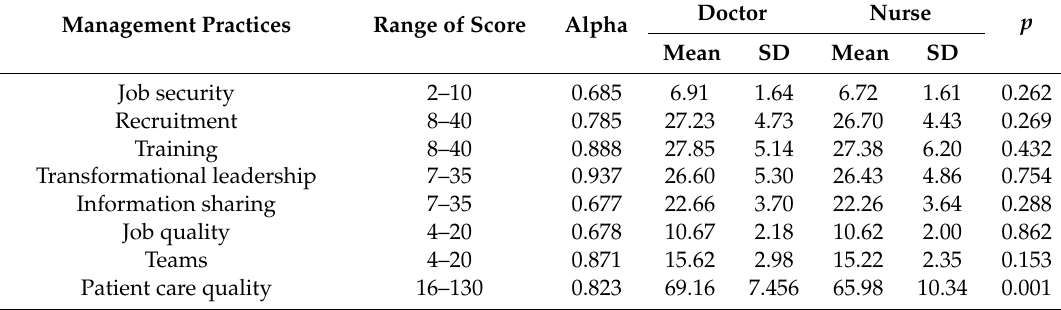
Table 2. Perceptions of doctors and nurses on management practices and patient care